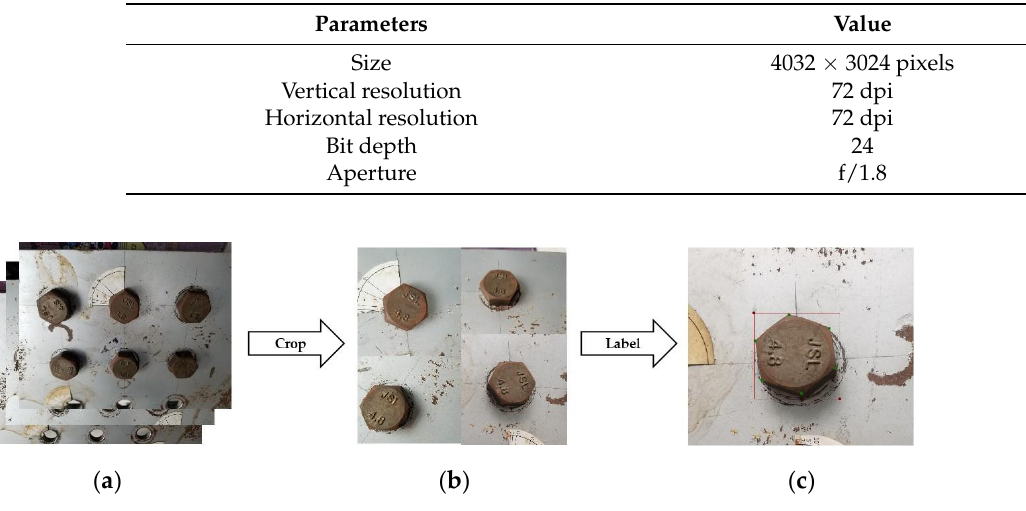
Figure 3. The test structure.